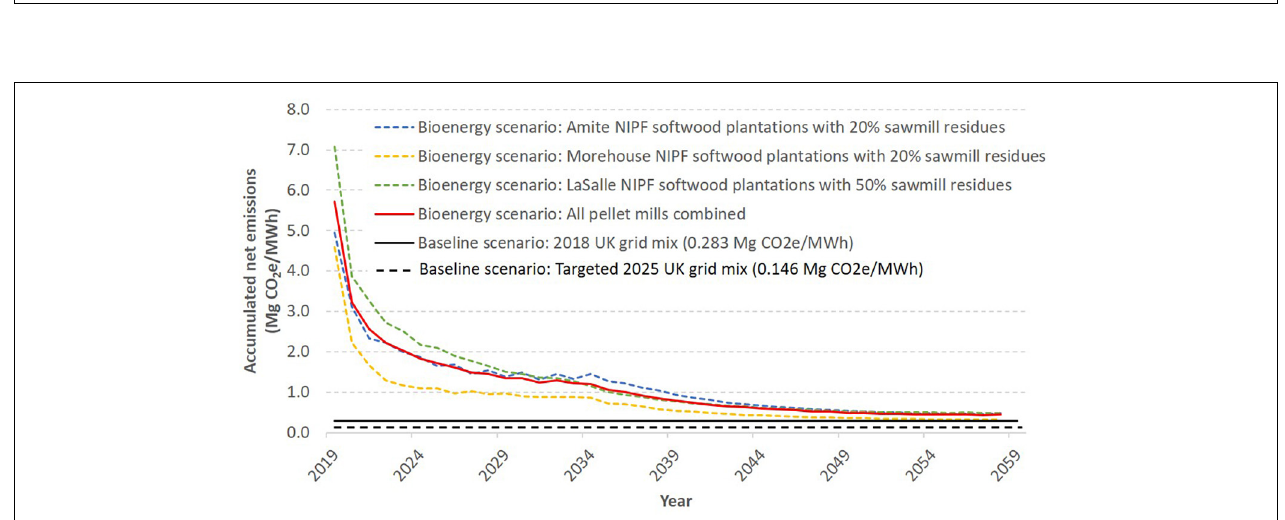
FIGURE 5 | Accumulated net GHG emissions per MWh of electricity produced in the UK with pellets from Drax’s mills in the southeastern U.S compared to a baseline scenario using the 2018 grid mix (black solid line) and the targeted 2025 UK grid emission profile (black dashed line).